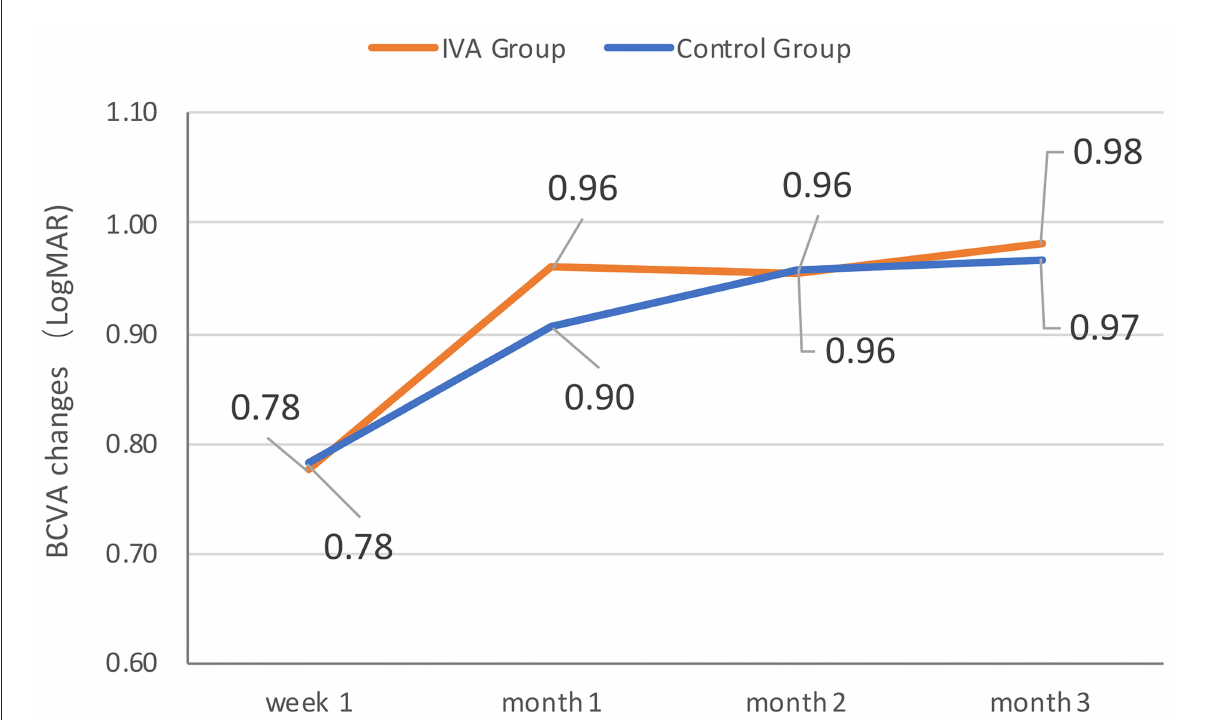
FIGURE3 The mean best-corrected visual acuity (BCVA) change comparing to baseline during follow-up in the two groups. The mean BCVA change in logMAR (Logarithm of the Minimum Angle of Resolution) scale at week 1, month 1, month 2, and month 3 after surgery comparing to baseline in the preoperative intravitreal aflibercept (IVA) injection group and control group.